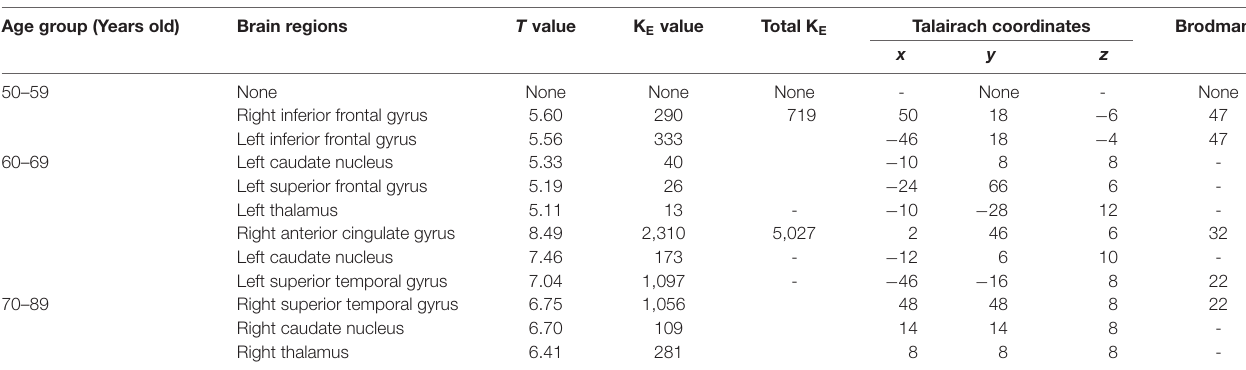
TABLE 4 | Brain regions with decreased metabolism in